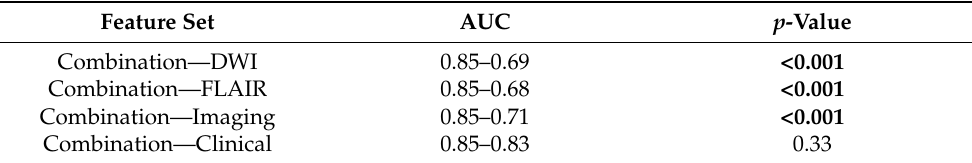
Table 2. DeLong’s test p -values for pairwise AUC comparisons ( α = 0.05), with the highest AUC as a reference. Statistically significant results are provided in bold.